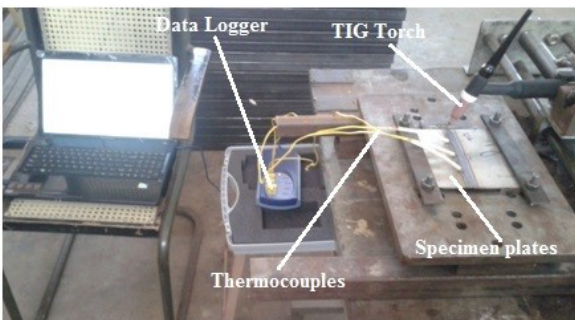
Figure 3: Experimental